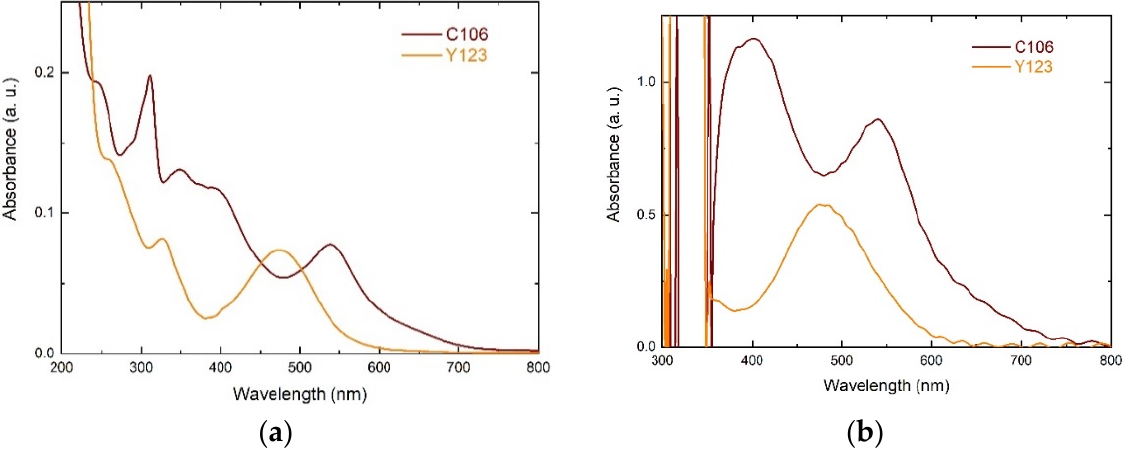
Figure 2. ( a ) Absorption spectra of dyes (C106, Y123) solution. ( b ) Absorption spectra of sensitized photoanodes with C106 and Y123 dyes (inset: photoanodes’ image).